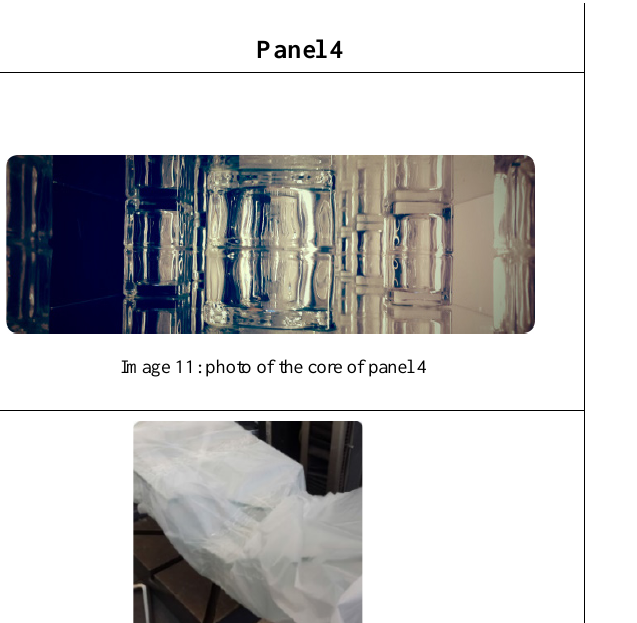
Image 10: fracture pattern